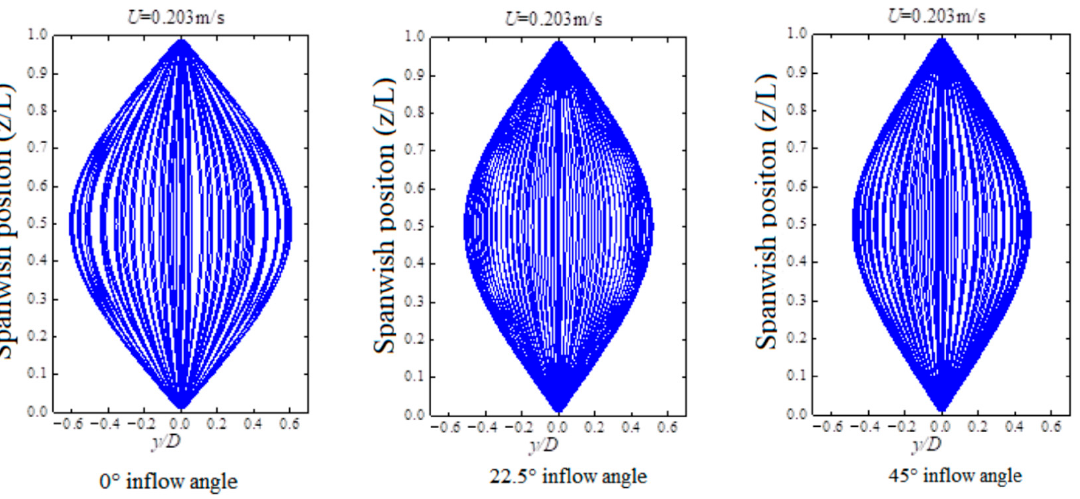
Figure 9. Displacement modal response of No. 4 tension leg with Ur = 7 under different inflow an- gles.